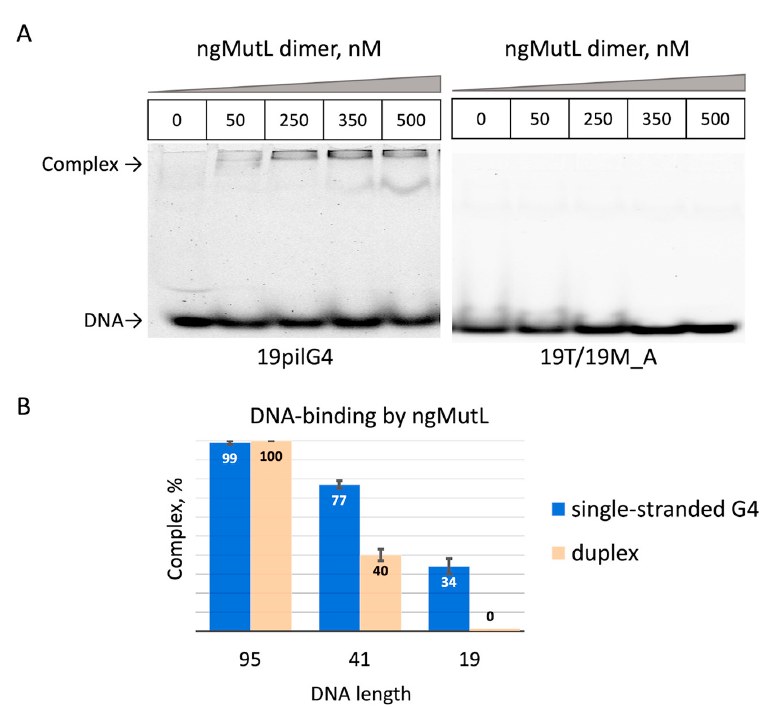
Figure 6. Comparative binding efficiency of ngMutL to single-stranded G4-containing DNA ligands and their duplex versions. Representative electropherograms of ngMutL binding to 19pilG4 and to double-stranded 19T/19M_A ( A ). Efficiency of ngMutL complex formation with 95-, 41-, and 19-mer DNA ligands; both single- and double-stranded ( B ). DNA probes labeled in TAMRA (20 nM) were incubated for 10 min on ice with 500 nM ngMutL (per dimer) in 20 mM HEPES buffer (pH 8.0) containing 100 mM KCl, 0.5 mg/mL BSA, and 1 mM DTT and then analyzed in a non-denaturing 6% polyacrylamide gel in TAE bu ff er at 4 °C. Error bars represent standard deviations. The calculation was carried out for at least three independent experiments.